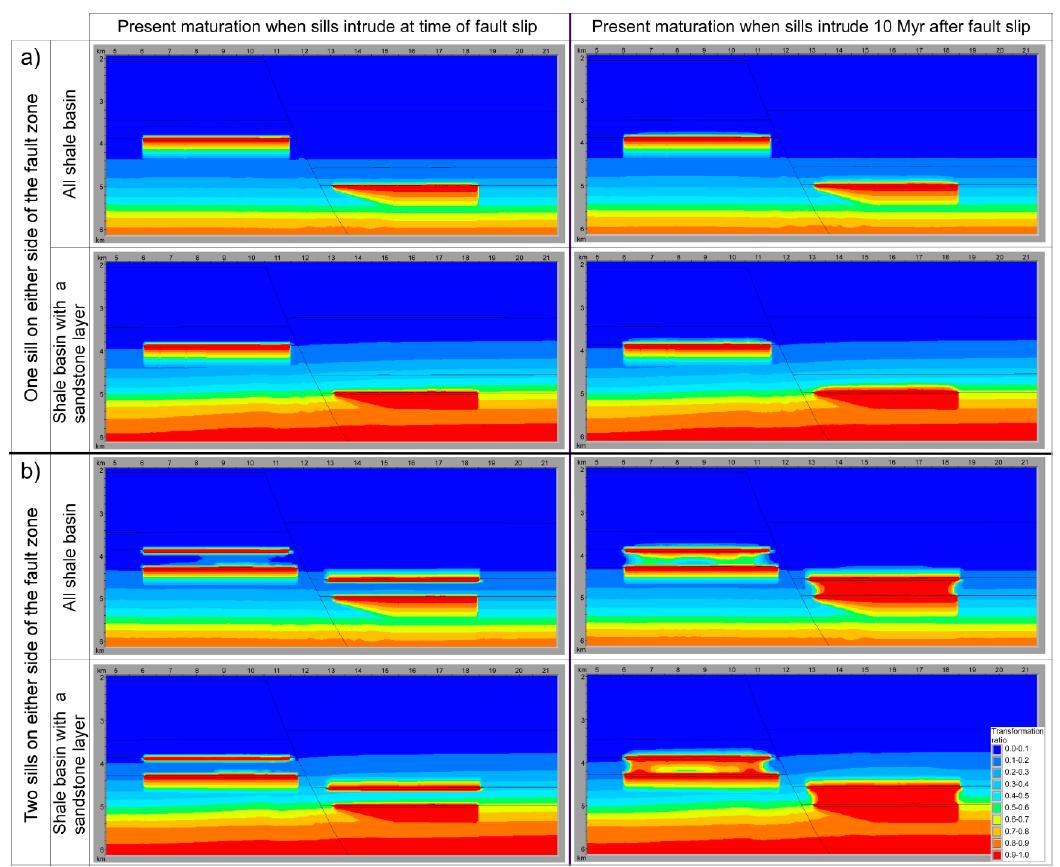
Figure 18. ( a ) Calculated maturation for one sill intruding on either side of the fault zone. ( b ) Calculated maturation for two sills intruding on both sides of the fault zone. Left side show results for sills intruding at time of fault slip. Right side show results for sills intruding 10 Myr after fault slip.